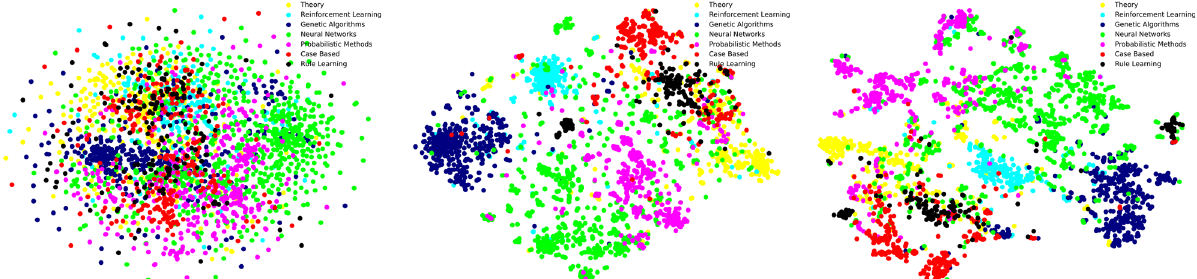
Figure 3. t-SNE visualization of Cora graph from the raw features (left), GraphSAGE-mean (middle), and the GANR (right).